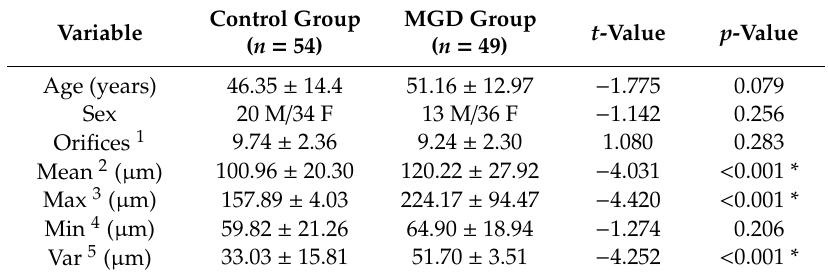
Table 1. The di ff erences in meibomian openings between normal subjects and patients with meibomian gland dysfunction (MGD).